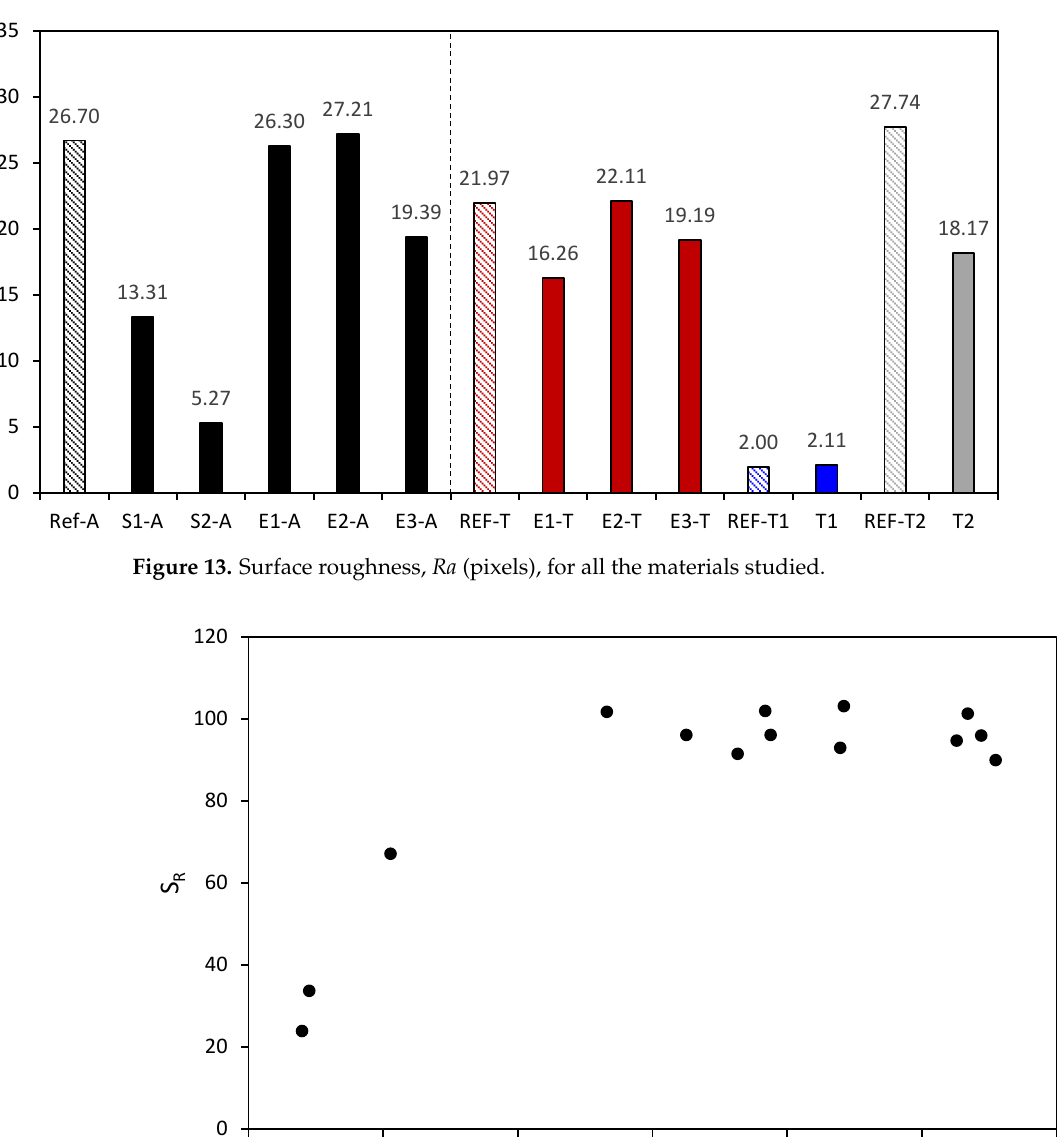
Figure 12. 3D roughness profiles and images for ( a ) reference asphalt (Ref-A) and ( b ) photocatalytic slab S2-A.